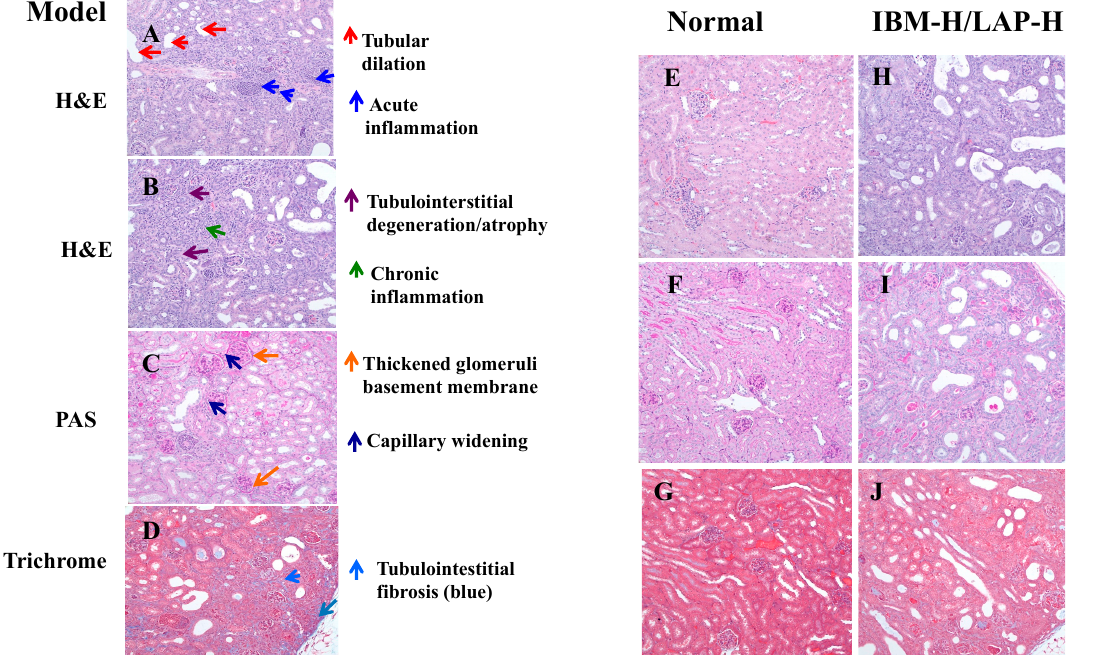
Figure 2. Histopathological evaluation of kidney lesions. Representative histopathology slides from the adenine-induced CKD mice showing tubular dilation and acute inflammation (A), tubulointerstitial degeneration/atrophy and chronic inflammation (B), thickened glomeruli basement membrane and capillary widening (C), and tubulointerstitial fibrosis (D). The representative histology slides from the normal mice showing no lesions (E-G), and the representative histology slides from the effective treatment mice showing reduced lesions (H-J).